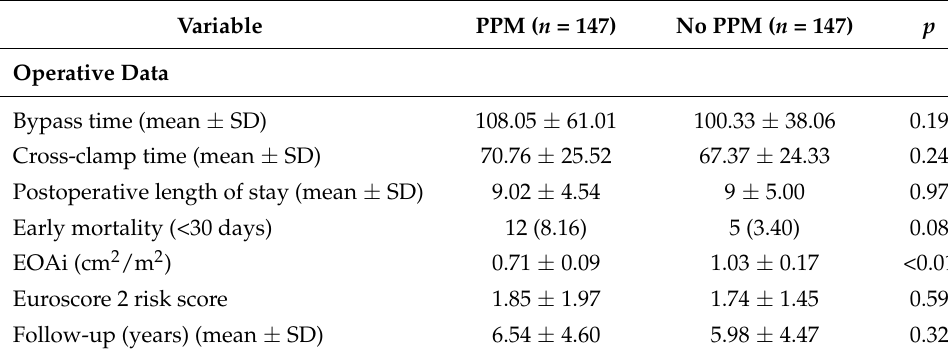
Table 3. Operative data of the matched sample.